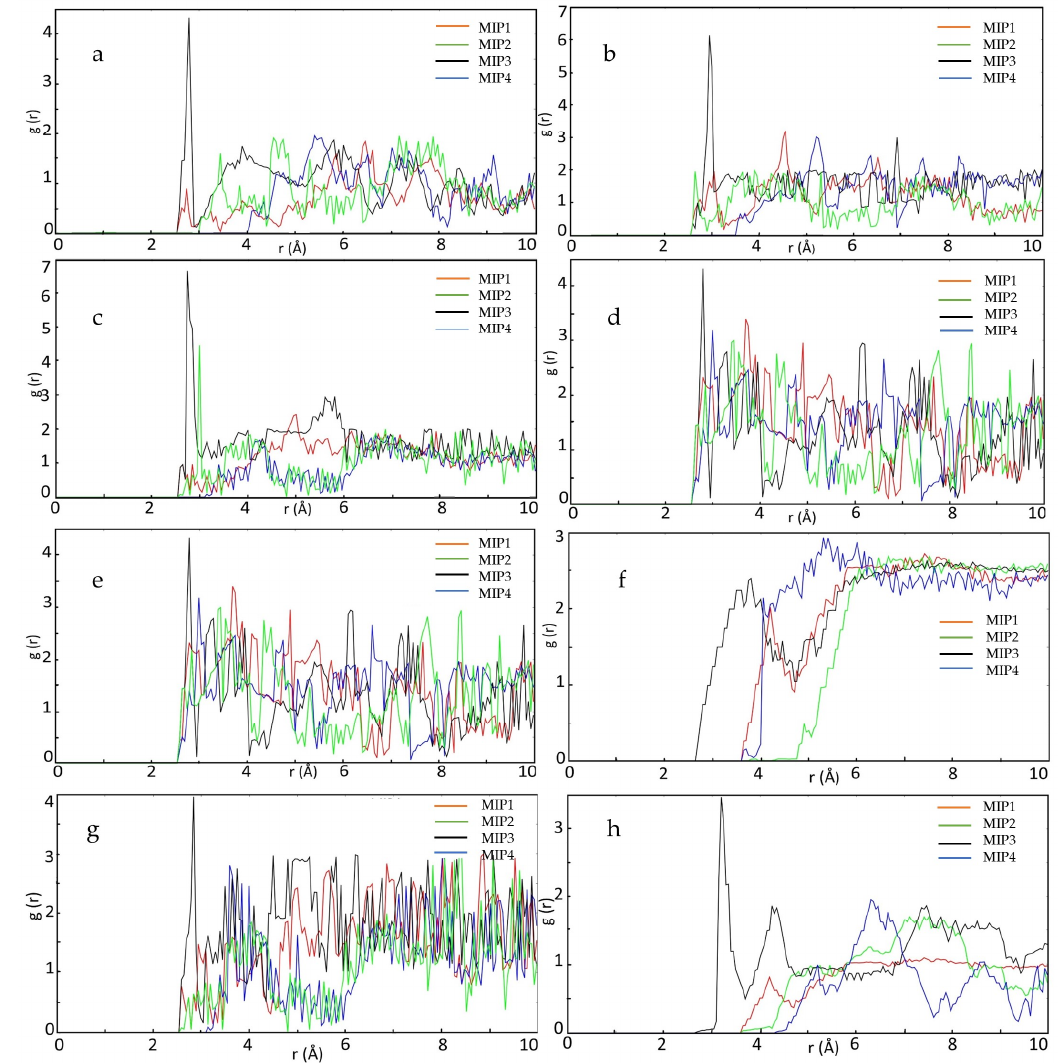
Figure 2. RDF display the probability of SLX oxygen atoms at distinct separation distances from HEMA hydrogen atoms: ( a ) TO1-MH, ( b ) TO2-MH, ( c ) TO3-MH, ( d ) TO4-MH, ( e ) TO5-MH, ( f ) TO6- MH, ( g ) TO7-MH, and ( h ) TH1-MO; r is a certain distance between atoms. The effect of the crosslinker on the interaction between SLX with HEMA, between TH (atom H labeled in SLX) and CO (atom C labeled in crosslinker), is depicted in Figure 3. EGDMA showed peaks from 1.5 to 2.86 at a distance of 1.8–3.2 Å, while TRIM did not show this peak in that radius, which means that there is no hydrogen bond between the